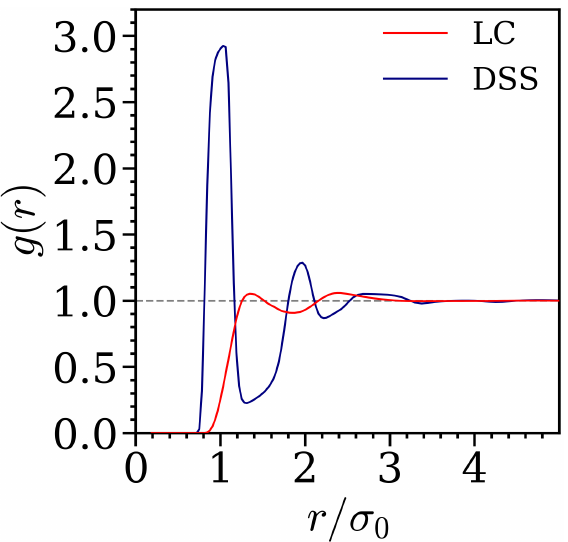
Figure 4. Variation of the pair correlation function, g ( r ) , as a function of distance for the LCs and DSS at the density, ρ = 0.36. The grey dashed line represents the value of g ( r ) equal to